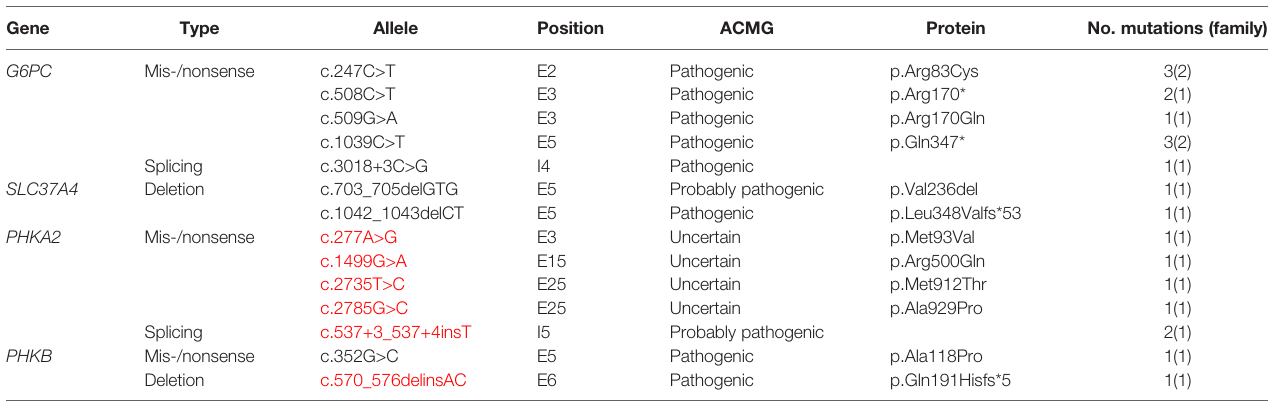
TABLE 3 | Summary of glycogen storage disease-related variants identi fi ed.